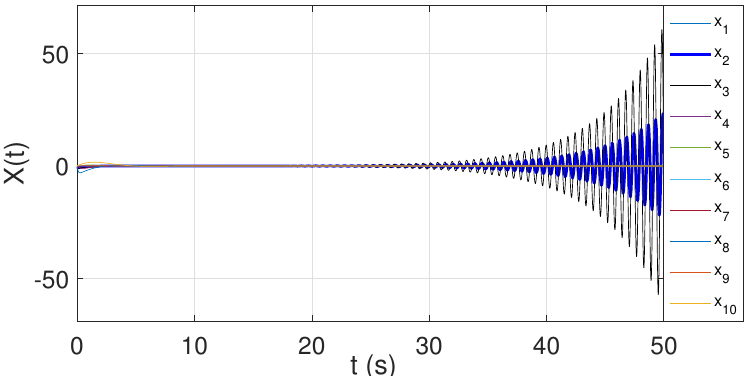
Figure 4. The NCS system under a TDS attack of τ = 0.19 s at the instant t 0 = 1 s.